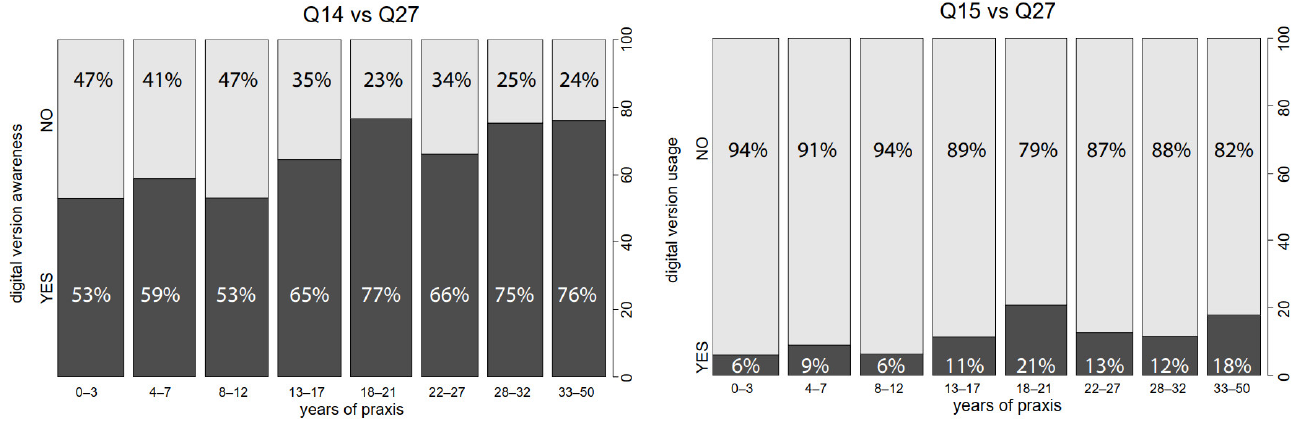
Figure 12. The influence of years of praxis (Q27) on the awareness of the digital version (Q14) and usage of this version (Q15).